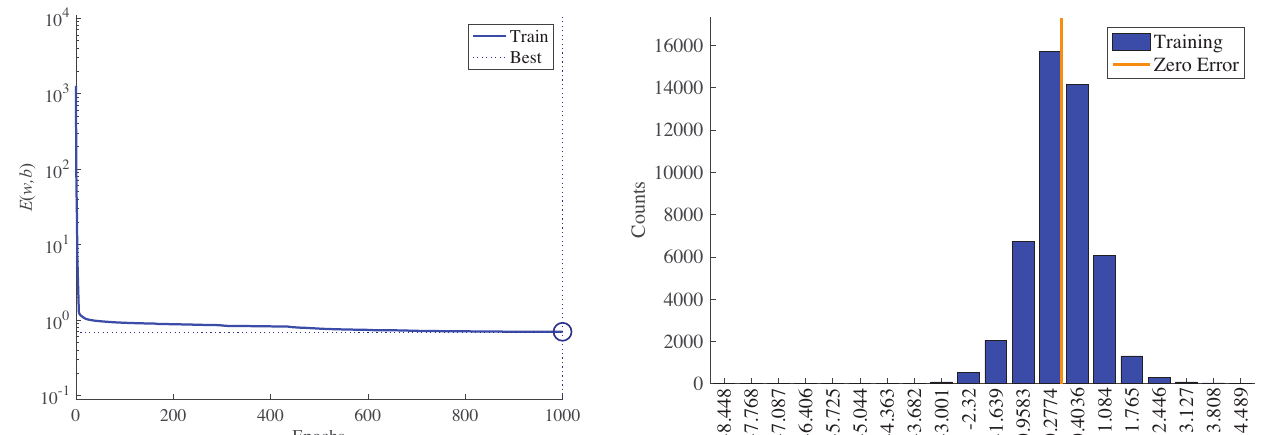
Figure 14. Minimization of the MSE, E ( w , b ) , during training of WT1 ( left ). Error histogram with 20 bins of final training error over all training samples for WT1 ( right